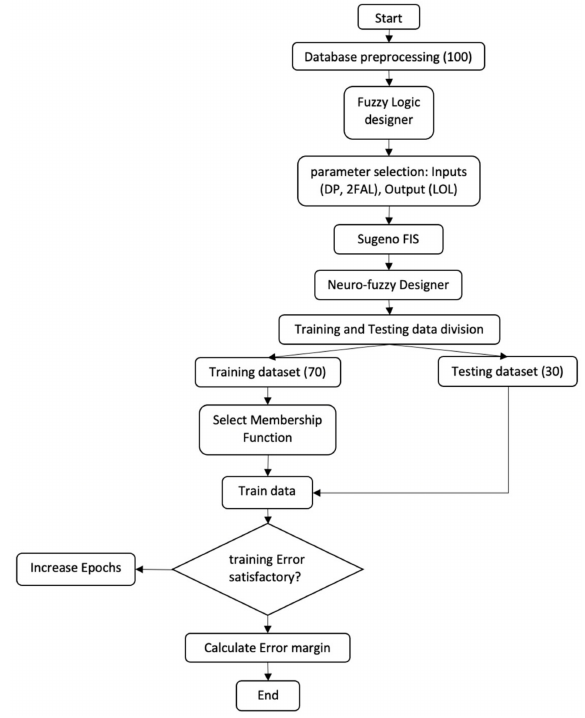
Figure 1. Proposed ANFIS